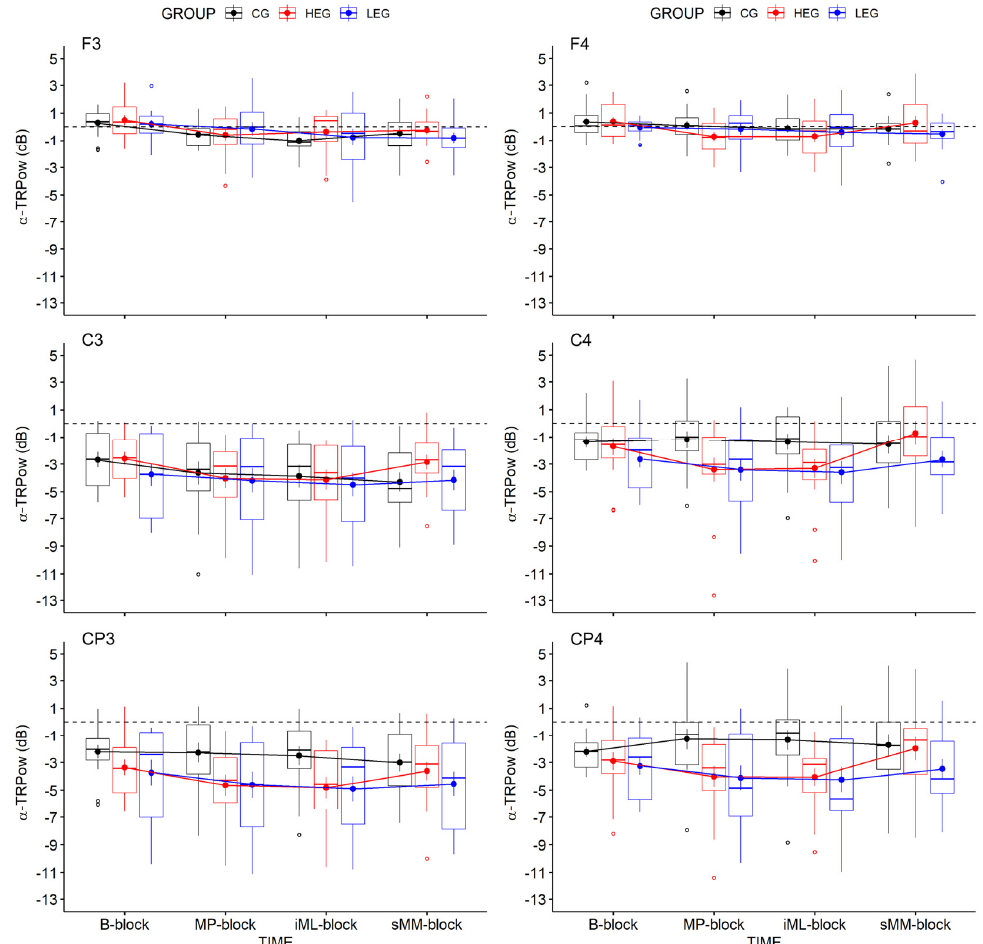
Figure 4. Illustration of changes in α -TRPow over the 4 measurement blocks included in the statistical analyses: Boxplots shown also contain RMSE means and (±) SEM per group (HEG, LEG, and CG). Negative values indicate decreased TRPow, representing increased cortical activation. Outliers are marked as values below the first quartile (–1.5 × IQR) or above the third quartile (+1.5 × IQR) (see Supplementary Table S2 for mean values and SD of α -TRPow).